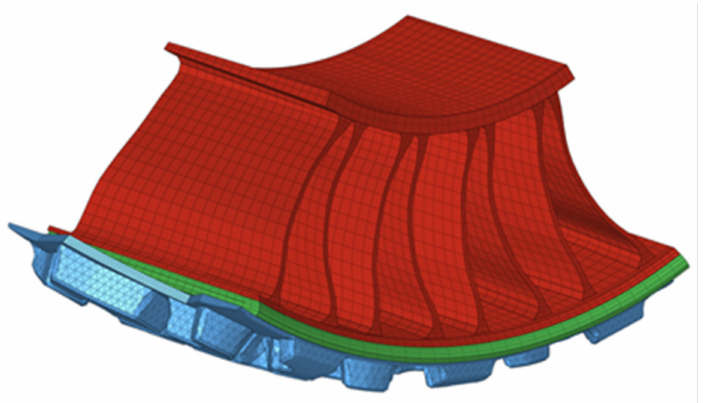
Figure 13. FE model of the 60 ◦